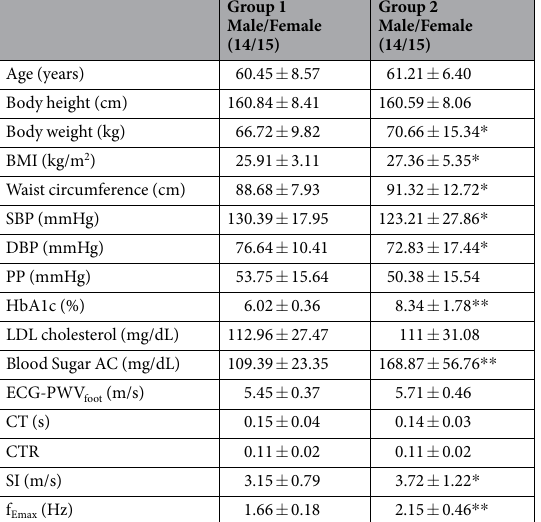
Table 1. Comparisons of demographic, anthropometric, serum biochemical, and computational parameters between diabetic and non-diabetic subjects. Group 1 = Healthy upper middle-aged subjects, Group 2 = Diabetes mellitus subjects. Value are expressed as mean ± SD. BMI = Body mass index; SBP = Systolic blood pressure; DBP = Diastolic blood pressure; PP = Pulse Pressure; HbA1c = Glycated hemoglobin; LDL = Low density lipoprotein; Blood Sugar AC = Fasting blood sugar; ECG-PWV foot = Electrocardiography-pulse wave velocity of foot; CT = Crest time; CTR = Crest time ratio; SI = Stiffness index; f Emax = Instantaneous energy of maximal energy. * p < 0.05 Group 1 vs. Group 2, ** p < 0.001 Group 1 vs. Group